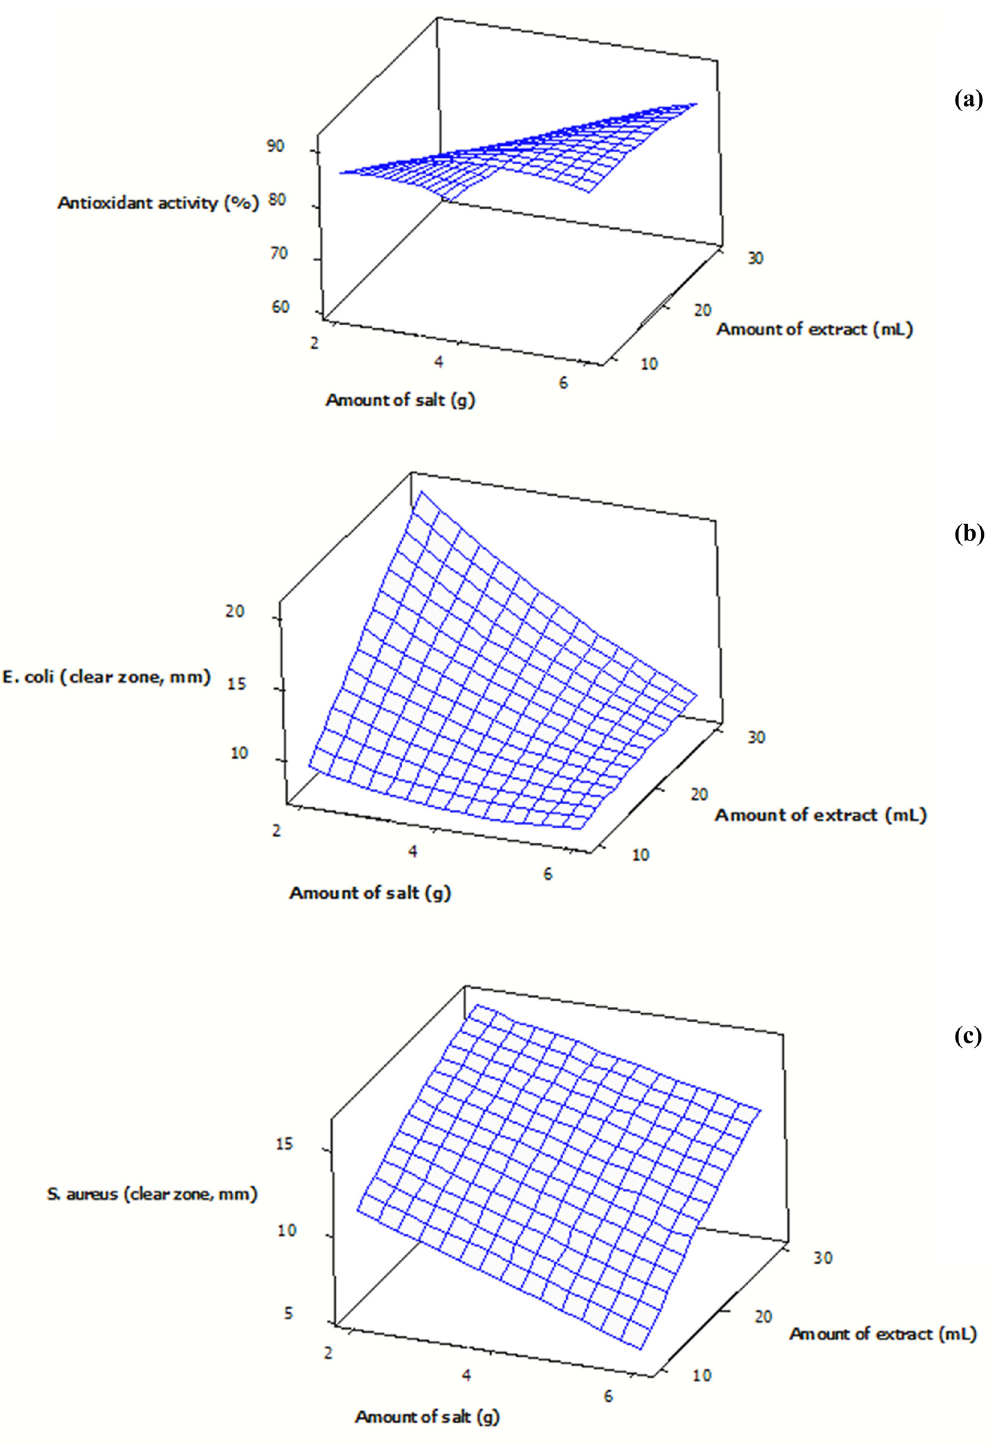
Figure 2: Surface plots for antioxidant activity ( a ) , antibacterial activities against E. coli ( b ) and S. aureus ( c ) of the synthesized ZnO NPs, as function of amounts of zinc salt ( g ) and clove extract ( mL ) maximum antioxidant and antibacterial activities. Obtained 20.30 mL clove extract could result in forming ZnO NPs with numerical optimization result revealed that the hydrother - an antioxidant activity of 85.23% and a bactericidal e ff ect mally green synthesis of ZnO NPs using 3.98 g zinc salt and toward E. coli and S. aureus , as manifested in the diameter